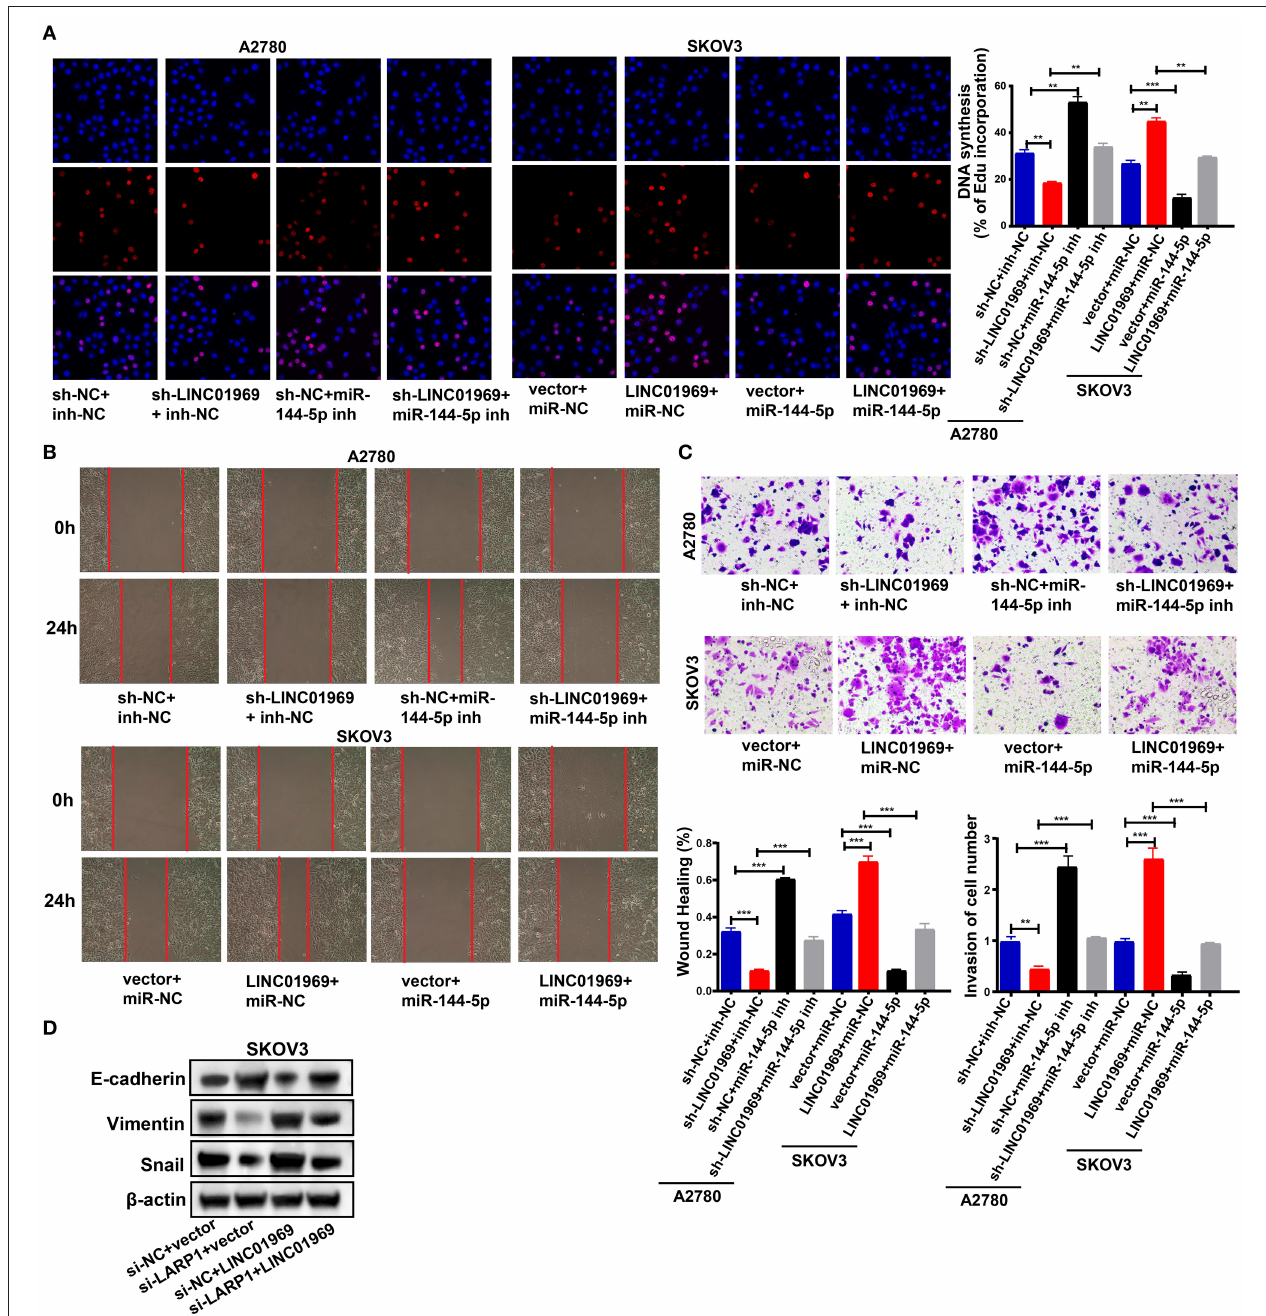
FIGURE 7 | LINC01969 /miR-144-5p axis regulates ovarian cancer (OC) progression. (A) Ethynyl-2-deoxyuridine (EdU) showed that miR-144-5p mimics treatment reversed the effect of LINC01969 overexpression on OC cell proliferation. (B) Wound healing assay showed that miR-144-5p inhibitor treatment reversed the effect of LINC01969 silencing on OC cell migration. (C) MiR-144-5p mimics treatment reversed the effect of LINC01969 overexpression on OC cell invasion. (D) The expression of epithelial–mesenchymal transition (EMT) markers were determined using Western blot assay. Data were presented as represent the mean ± SD of three independent experiments; ** P < 0.01, *** P < 0.001.